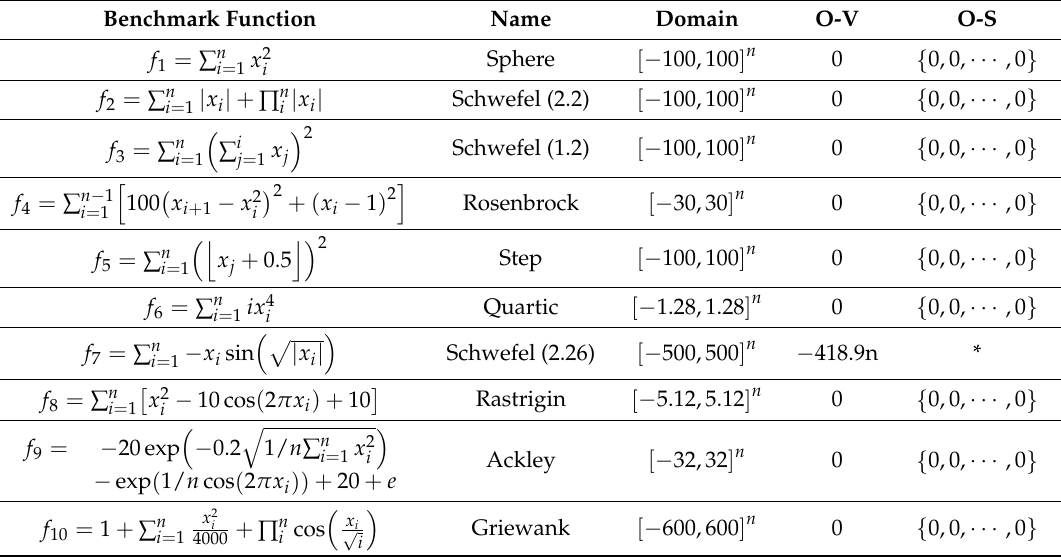
Table 1. Details of benchmark